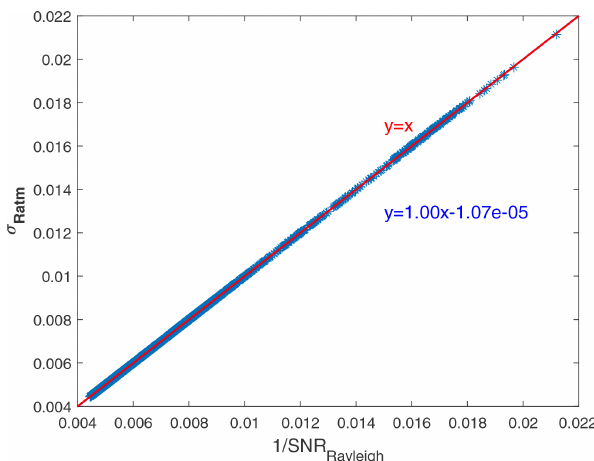
Figure A2. The scatter plot of the reciprocal SNR versus the un- certainty of the response function of the Rayleigh channel and their first order fitting relationship.